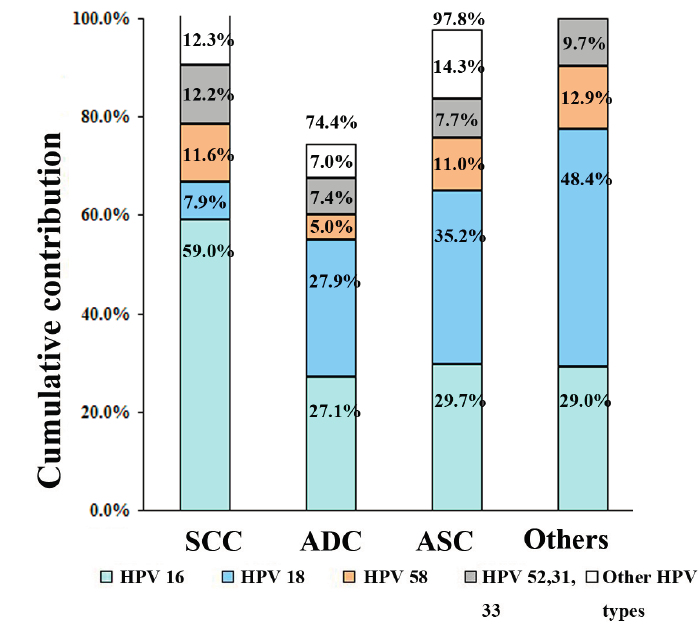
Figure 5. Cumulative contribution of HPV types for pathologic types of invasive cervical cancer. Attribution rates conferred by individual HPV types and cumulative attribution rates are